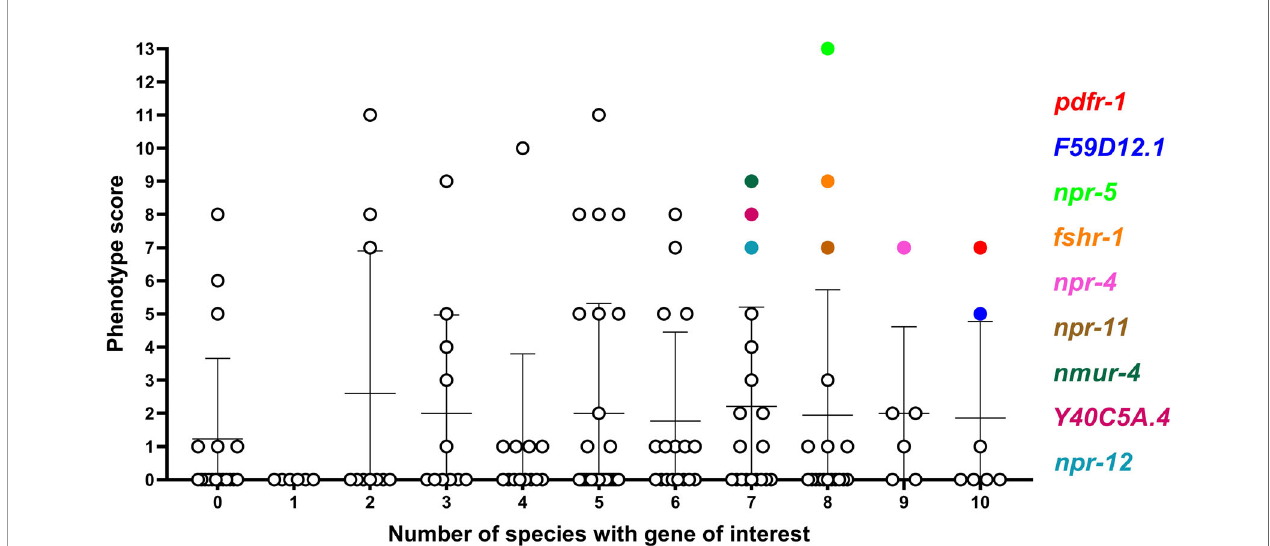
FIGURE 5 | Comparison of phenotype score and NP-GPCR conservation. Phenotype score (sum of all phenotype categories associated with each gene) was plotted against the number of species which possess an NP-GPCR of interest. There is a no statistically signi fi cant correlation (Spearman rho) between phenotype score and NP-GPCR encoding gene conservation. Only genes displaying both a high level of conservation and phenotype score are